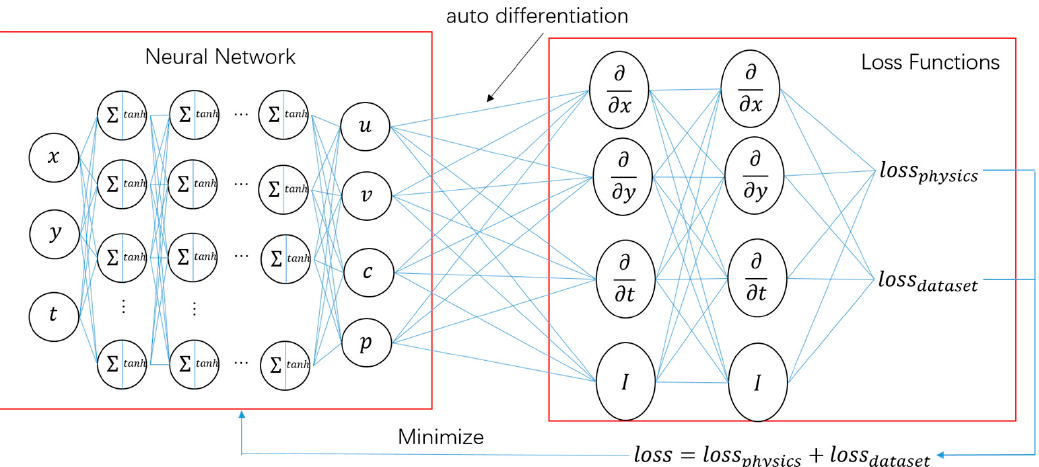
Figure 1. Architecture of the physics-informed neural network for fluid dynamics (note that the concentration fi eld is the only observable).